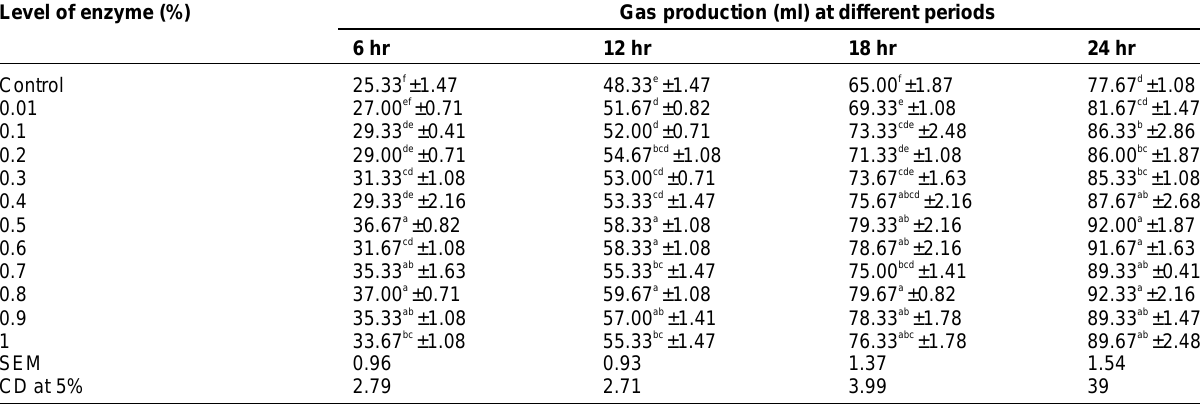
Table-2. Effect of fungal xylanase on in vitro gas production (ml) from dry jowar Level of enzyme (%)